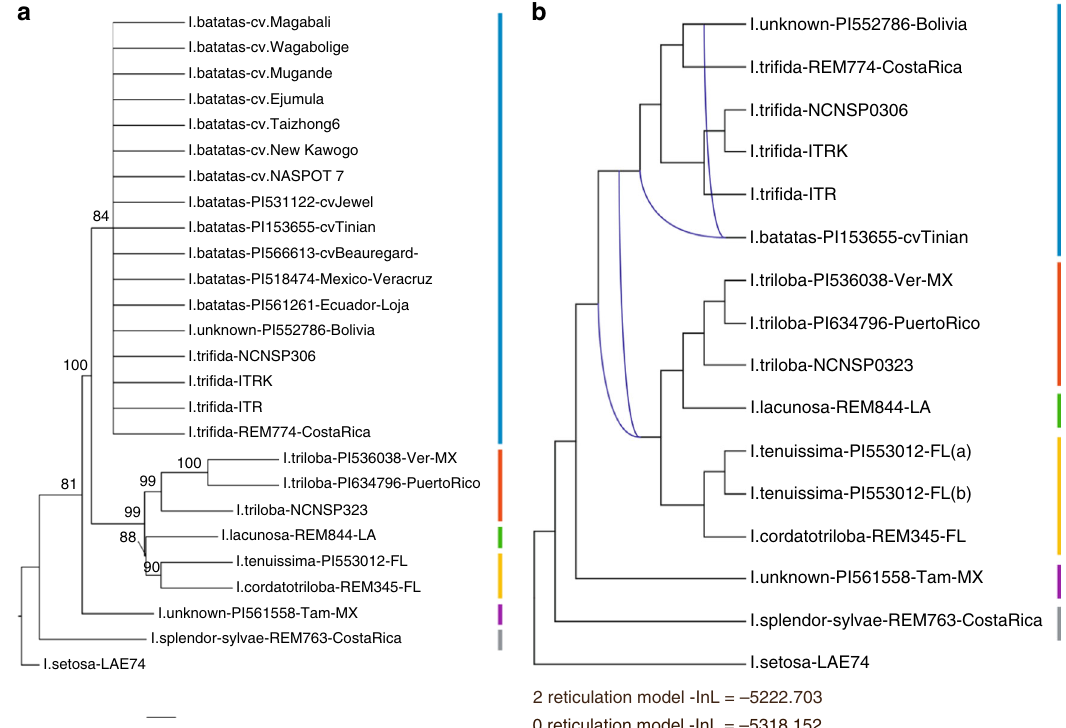
Fig. 6 Phylogenetic relationships among members of the Batatas complex. a Phylogenetic relationships among Batatas complex accessions inferred using the species-tree method ASTRAL-II. Bootstrap support values are shown next to the branches. Relationships among I. tri fi da and I. batatas accessions were not resolved. b Phylogenetic network of the Batatas complex including pseudolikelihood estimates for hybridization events in the ancestor of red, green and yellow clades as well as in the ancestry of cultivated sweetpotato. Blue lines indicate the two-reticulation events inferred in PhyloNet. Below the phylogenetic network are − log-likelihood scores for the tree generated in PhyloNet under the zero-reticulation model (Supplementary Fig. 20d) and the network estimated under the two-reticulation model. Color bars at the right of each tree denote the six inferred major